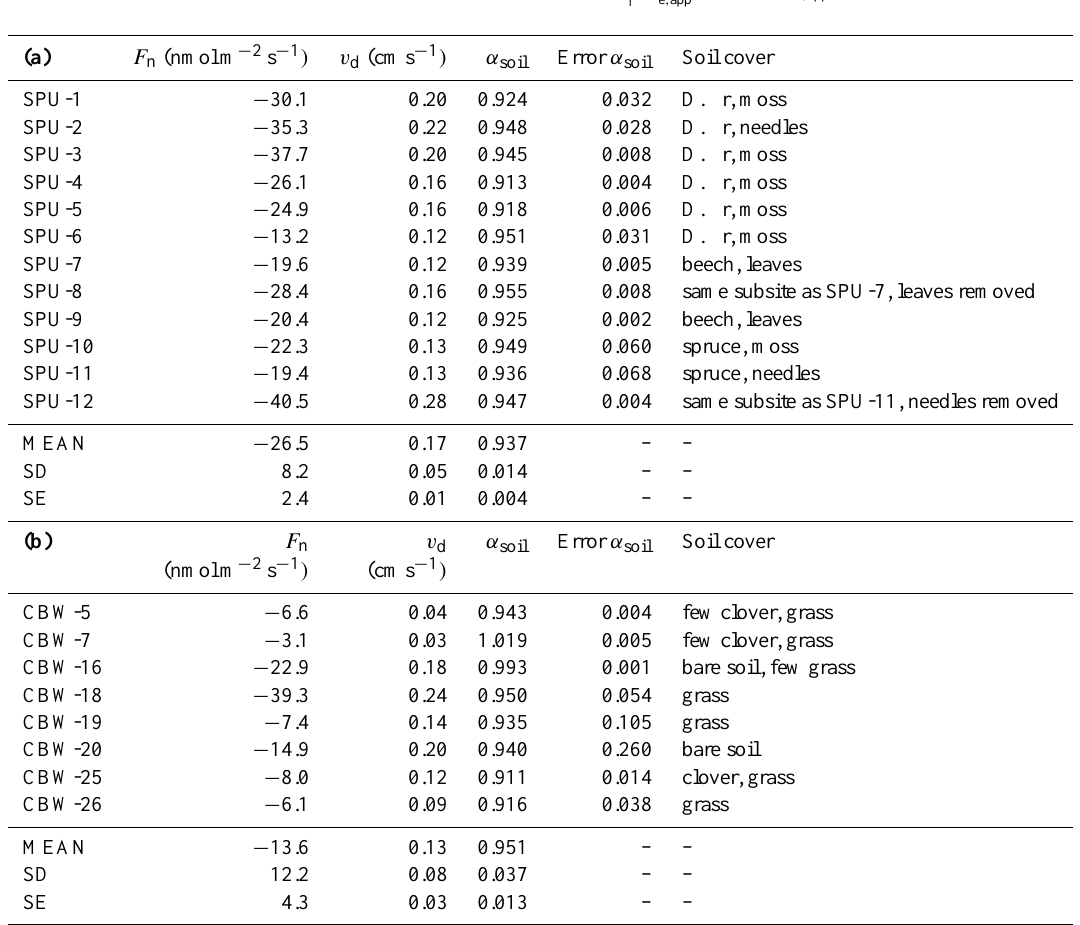
Table 1. The deposition velocity ( v d ) , fractionation factor ( α soil ) as well as its error estimate and soil cover information for each Speuld experiment (a) and Cabauw net-uptake experiment (b) . The SD represents standard deviation and SE represents standard error. The errors of α soil represent the 95% confidence interval (CI) for α soil , app obtained from ln